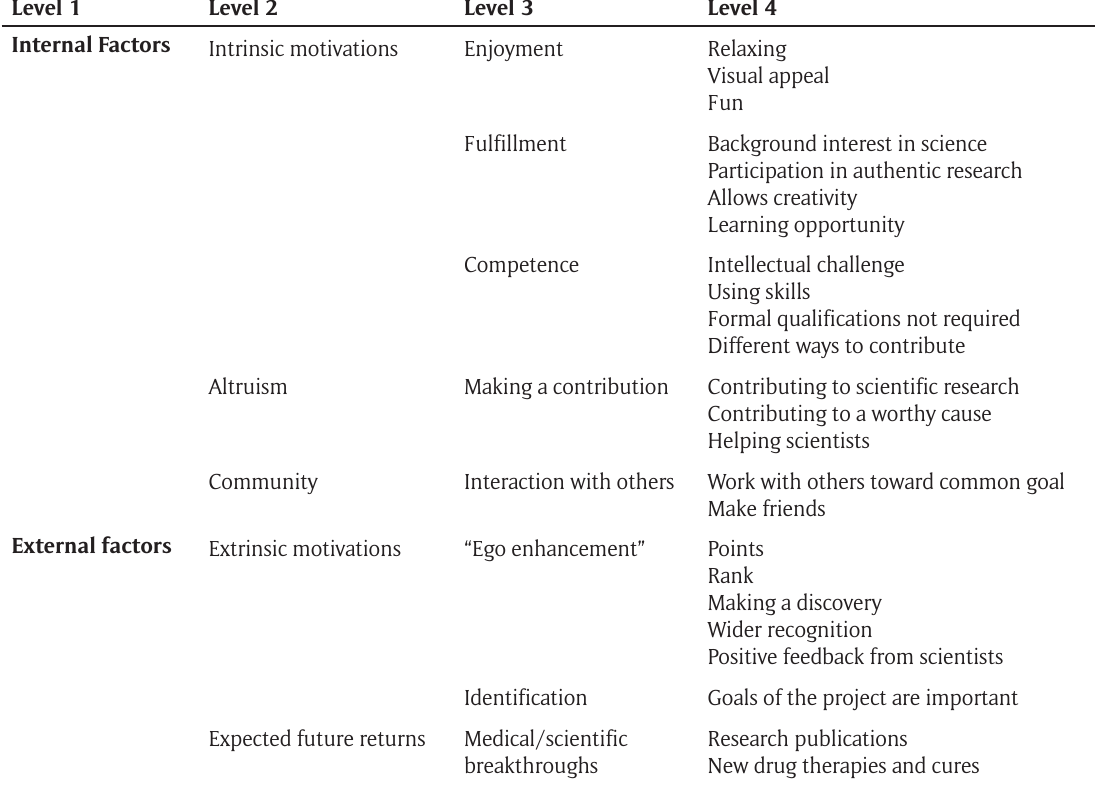
Table 4: Motivational framework for online citizen science. Level